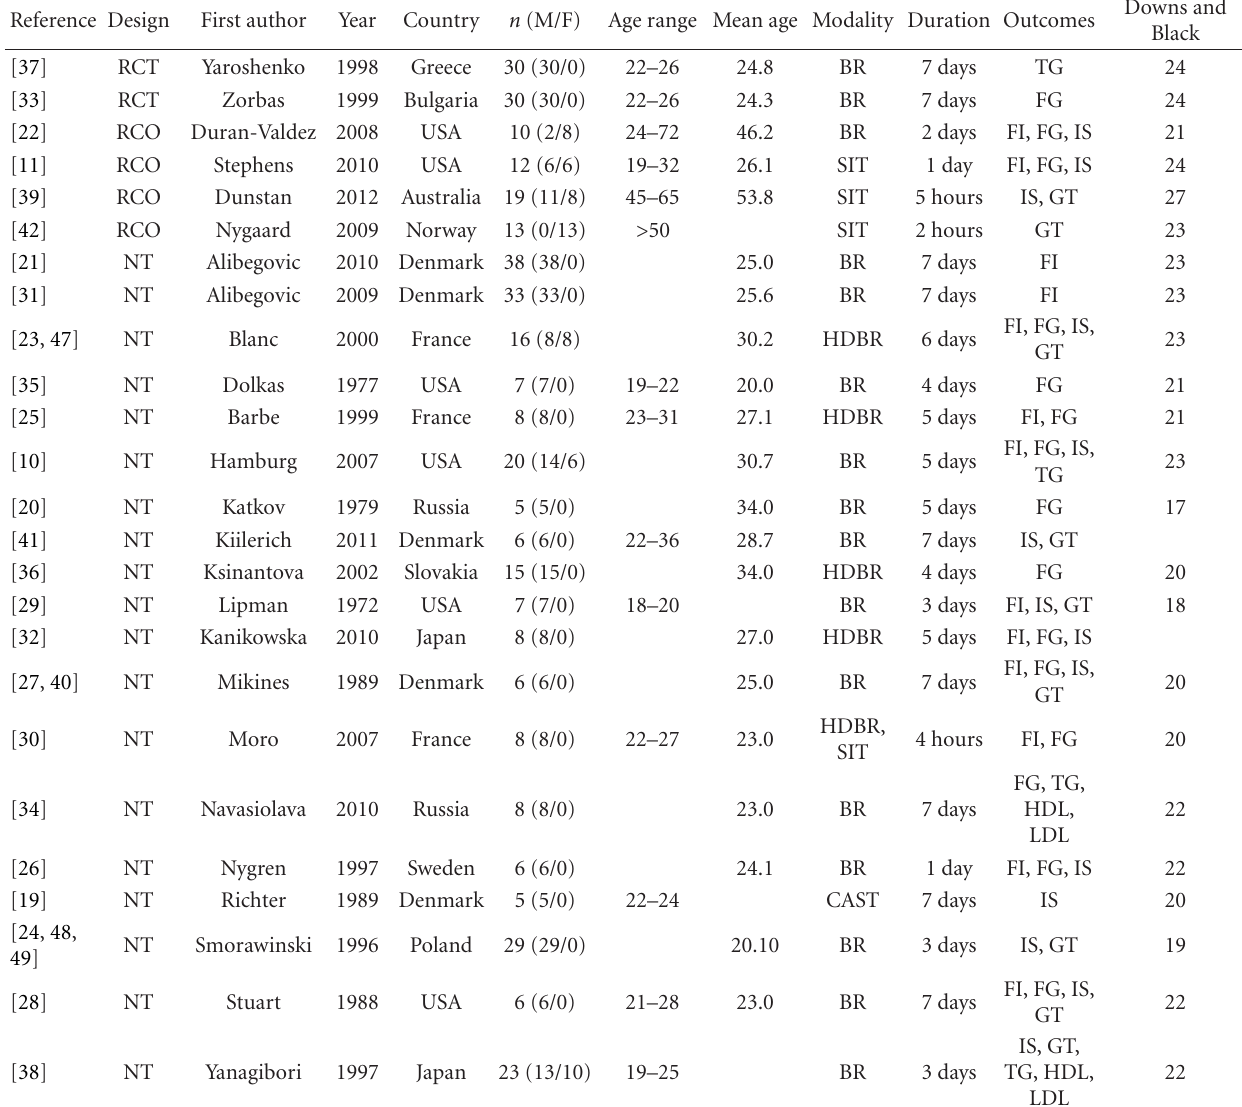
Table 1: Characteristics of included